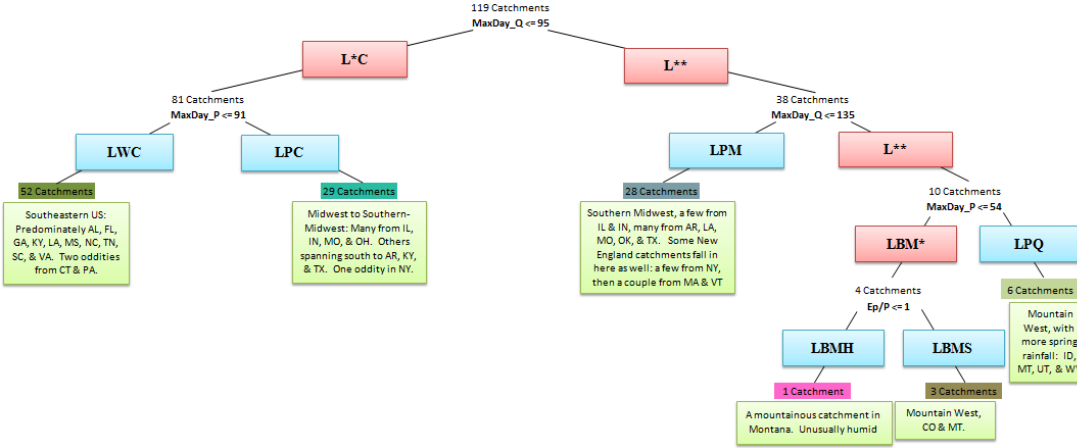
Fig. 9. Low seasonality, early precipitation peak: expanded (terminal nodes in blue).